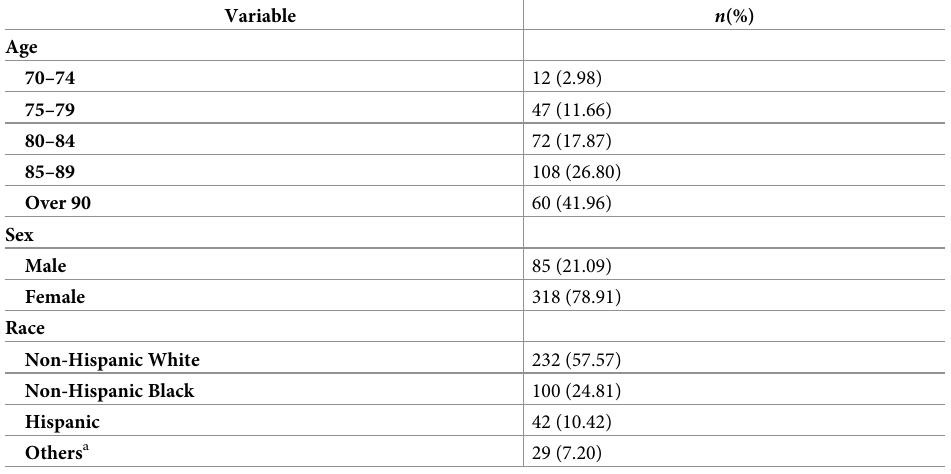
Table 1. The demographic characteristics of the study participants.